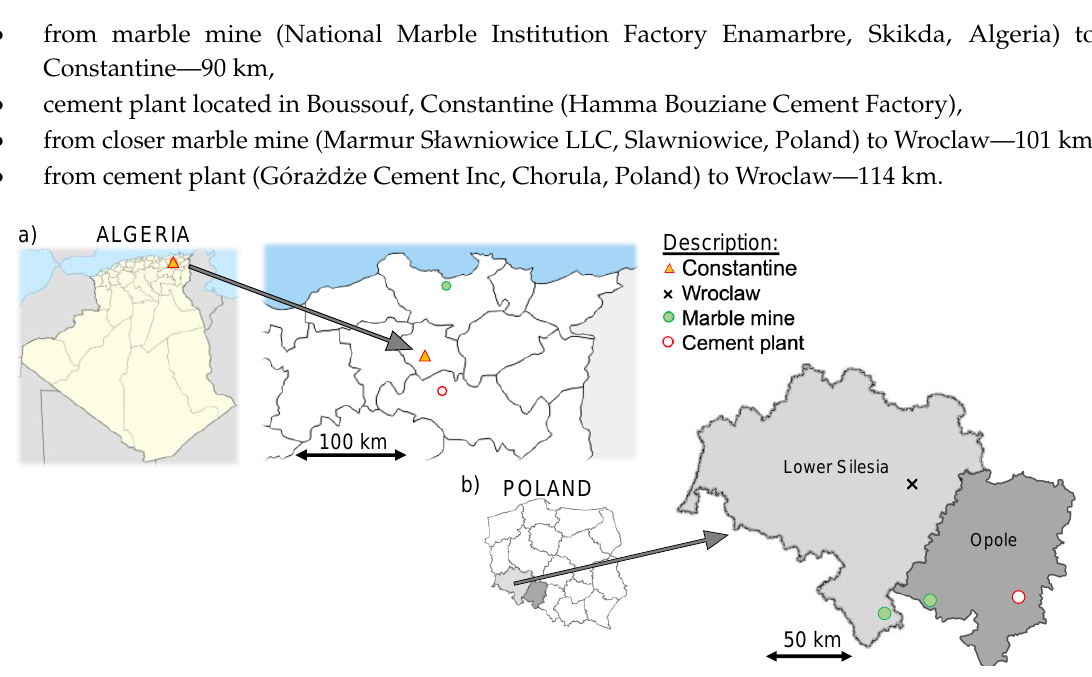
Figure 8. Scheme of the distance between potential location of use and materials suppliers for: ( a ) Algeria; ( b ) Poland.